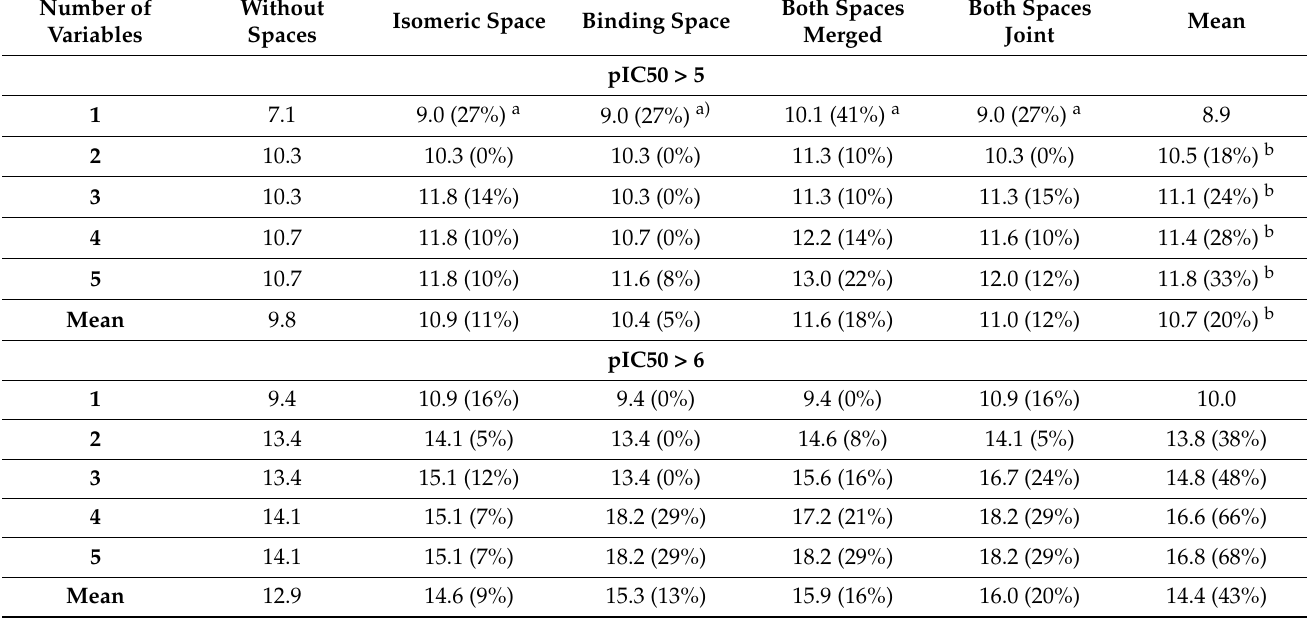
Table 2. Best EF1% values reached by the various consensus models developed using the PLANTS results plus the relative average values and the corresponding performance enhancements in percentage values. As described under Methods, the consensus equations were generated by linearly combining from two to five docking scores. The EF1% values referring to one variable correspond to the performances reached by single scoring functions.